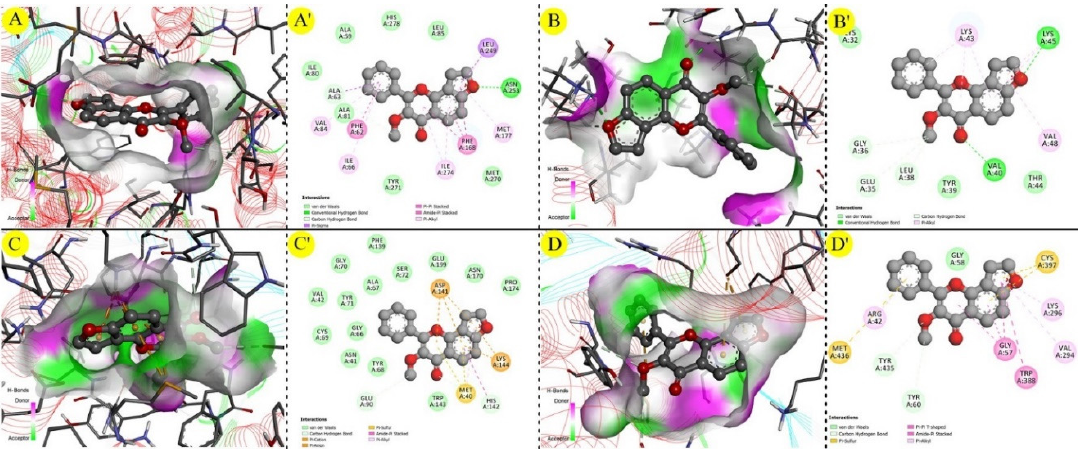
Figure 4. Molecular interactions of the natural karanjin against four putative drug targets of AD during study docking in 3D and 2D views (AutoDock); ( A & A ′ ) interaction against A 2A AR (PDB ID: 3EML); ( B & B ′ ) interaction against ASN (PDB ID: 1XQ8); ( C & C ′ ) interaction against COMT (PDB ID: 1H1D); and ( D & D ′ ) interaction against MAO_B (PDB ID:2C65), respectively. The 3D and 2D images were generated using the software Discovery Studio Visualizer. The grey spheres represent the ligand (karanjin), and the arrows indicate the interaction of the karanjin with the amino residues present in the protein. The green colored line indicates the hydrogen bond interaction with the amino acid residues.